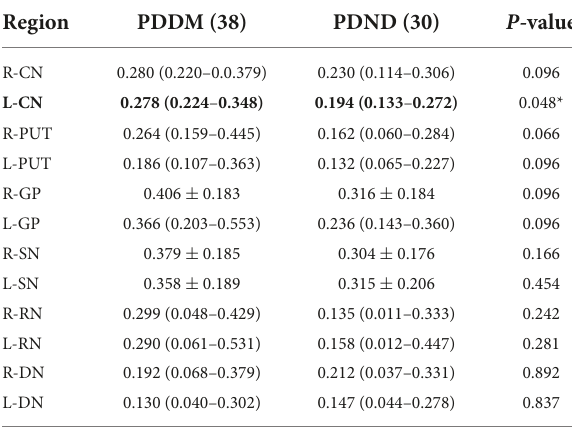
TABLE 7 V RII /V W of gray matter nucleus between PDDM group and PDND